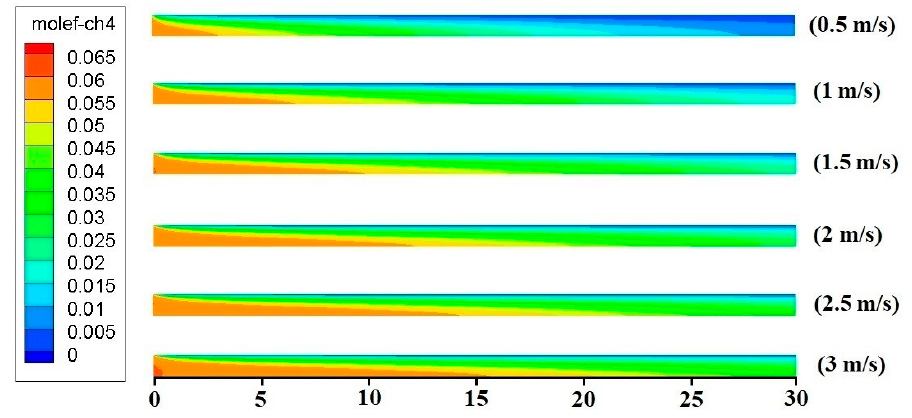
Figure 14. Distribution of methane concentration with different injection rates.